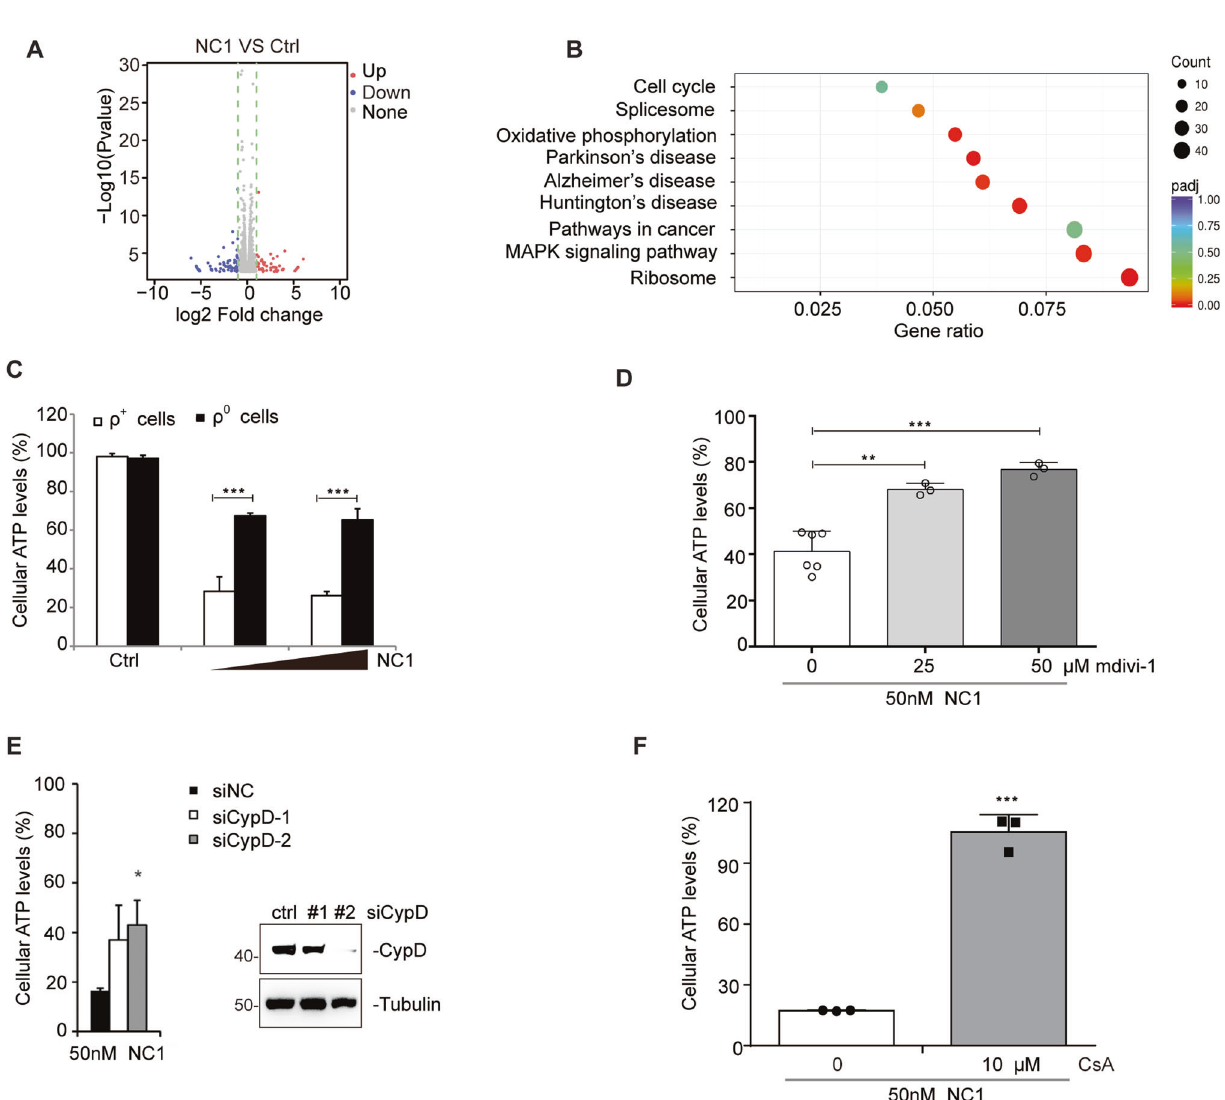
Fig. 5 Mitochondria is crucial for NC1-induced cell death. A Volcano plot of upregulated or downregulated genes in MCF-7 cells subjected to NC1 treatment. B The Ingenuity Pathway Analysis (IPA) of RNA-seq. C The mitochondria-depleted MCF-7 cells as well as the control cells were treated with NC1. Cell viability was determined by measuring cellular ATP levels. D MCF-7 cells were pre-treated by mitochondrial division inhibitor mdivi-1 (0, 25, 50 μ M) for 2 h, followed by NC1 (50 nM) for overnight to measure cellular ATP levels. E Inhibition of NC1- induced killing by knockdown of cyclophilin D (CypD). Cells were subjected to the knockdown of CypD using suitable siRNAs. Forty-eight hours post-transfection the cells were treated with NC1 (50 nM, left) to measure cellular ATP levels, and the ef fi cacy of the knockdown was determined by immunoblot (right). F MCF-7 cells were pre-treated by mitochondrial permeability transition pore (mPTP) inhibitor cyclosporin A (CsA, 5 μ M) for 2 h, followed by NC1 (50 nM) treatment for overnight to measure cell viability. Cell viability was determined by measuring cellular ATP levels. The data are represented as the mean ± SD of triplicate assessments. Asterisks indicate signi fi cance between the two groups indicated (* p < 0.05; ** p < 0.01, ** p < 0.001).